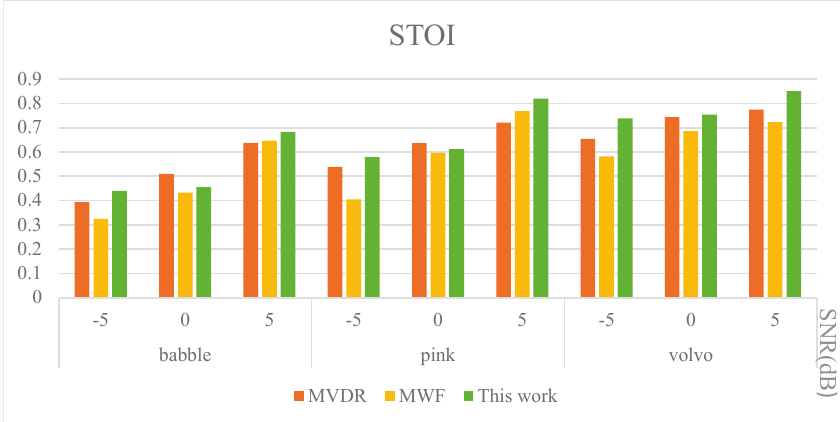
Figure 17. The comparison results of PESQin different SNRs under different daily noise scenarios.